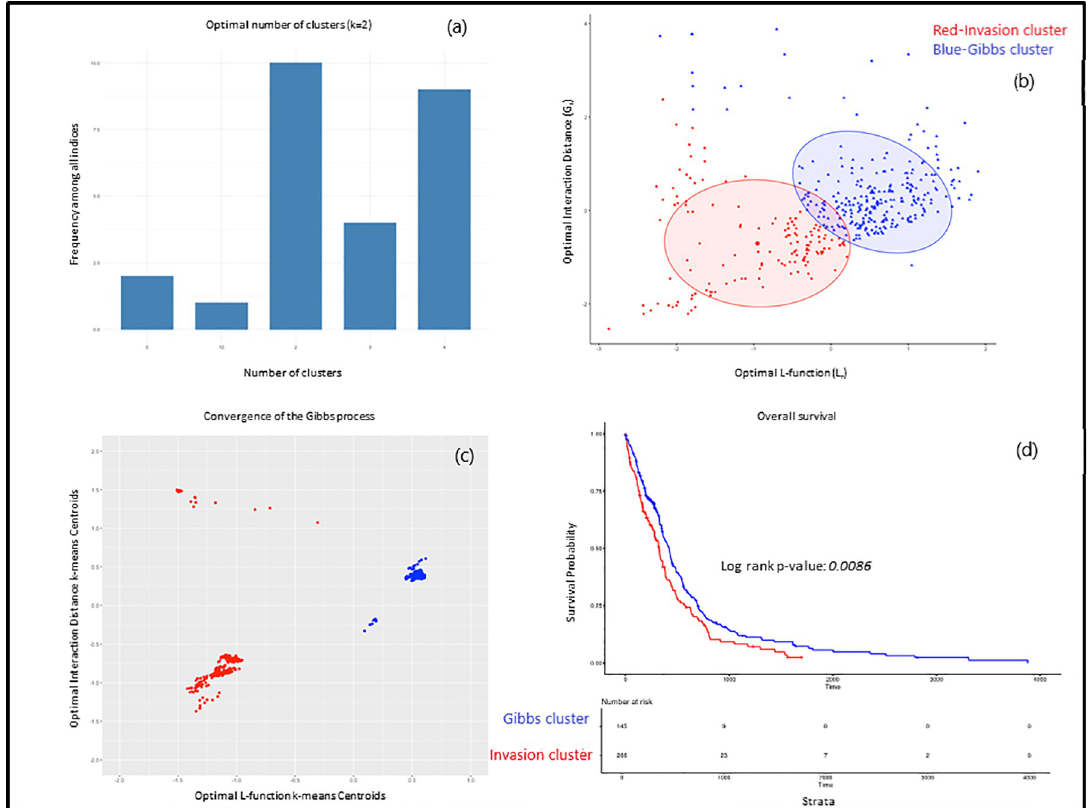
Fig 2. Convergence of the Gibbs